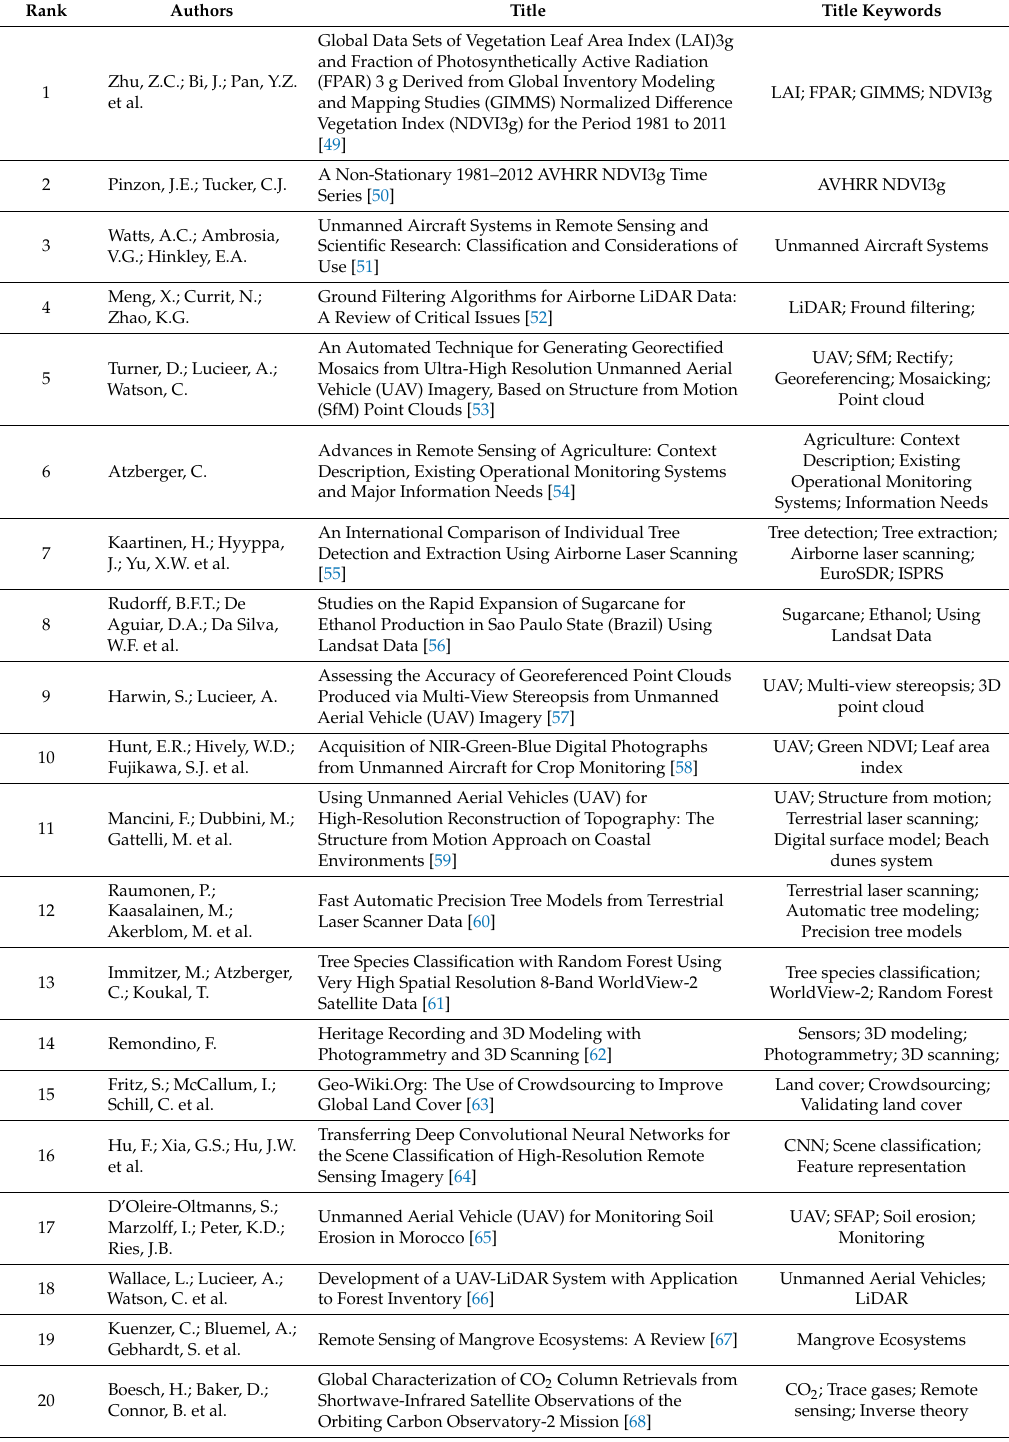
Table 4. The title analysis of the first 20 h-classic publications (Table 3) published by RS OAJ.